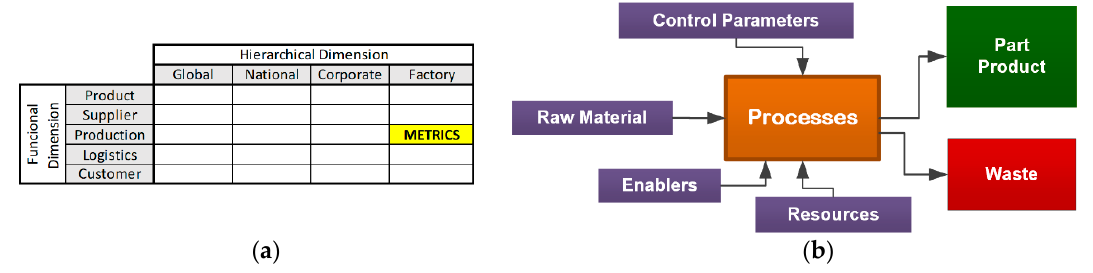
Figure 1. Dimensions selection sustainability indicators modeling. ( a ) Criteria for Metrics Selection [27]. ( b ) Generic Process Flow Diagram